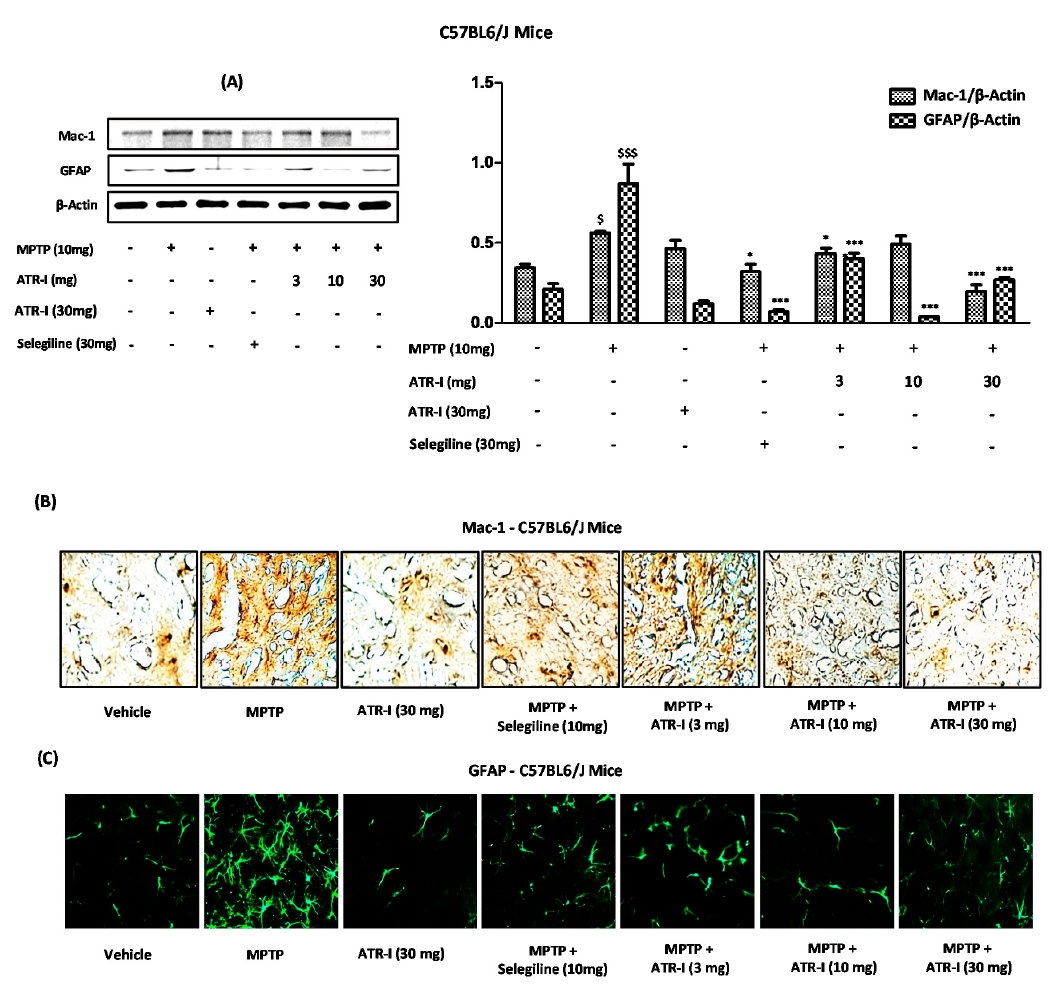
Figure 3. ( A ) Western blot for Mac-1 and GFAP expression in the STR ( n = 3). $ p < 0.05 and $$$ p < 0.001 vs. vehicle group; * p < 0.05, and *** p < 0.001 vs. MPTP-treated group; ( B ) Representative